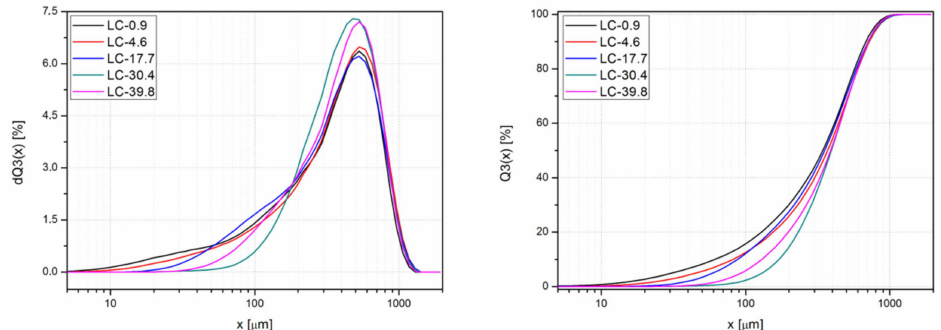
Figure 2. The particle size distribution curves Q3(x) and their derivatives dQ3(x) as a function of the particle size x obtained for the